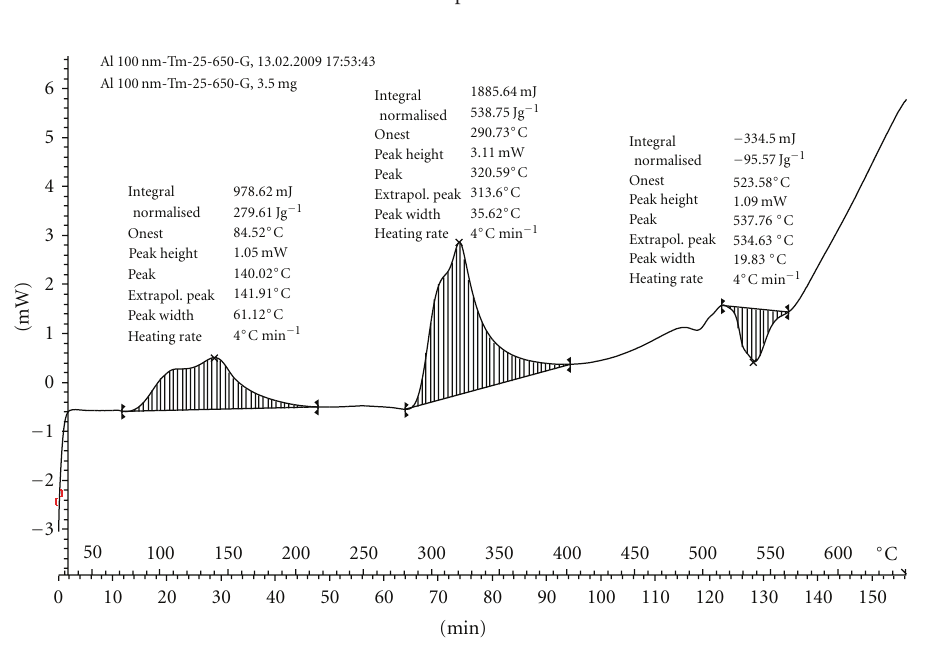
Figure 6: Thermal spectrum of 35 nm Al.